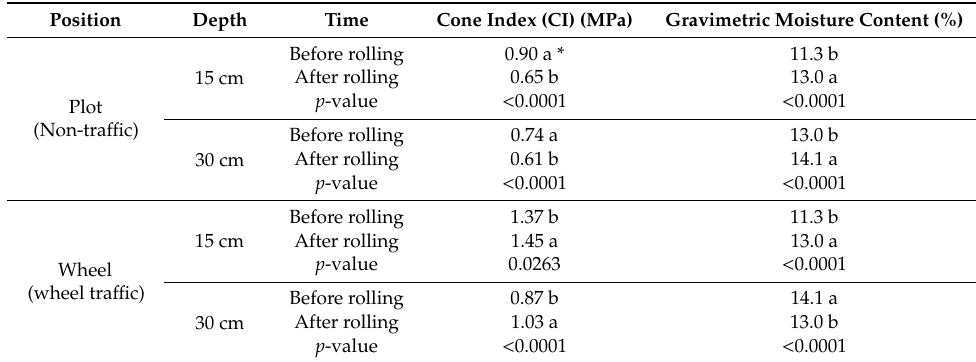
Table 8. CI values averaged over two depths (0–15 cm and 15–30 cm) and corresponding gravimetric soil moisture content in 2016 growing